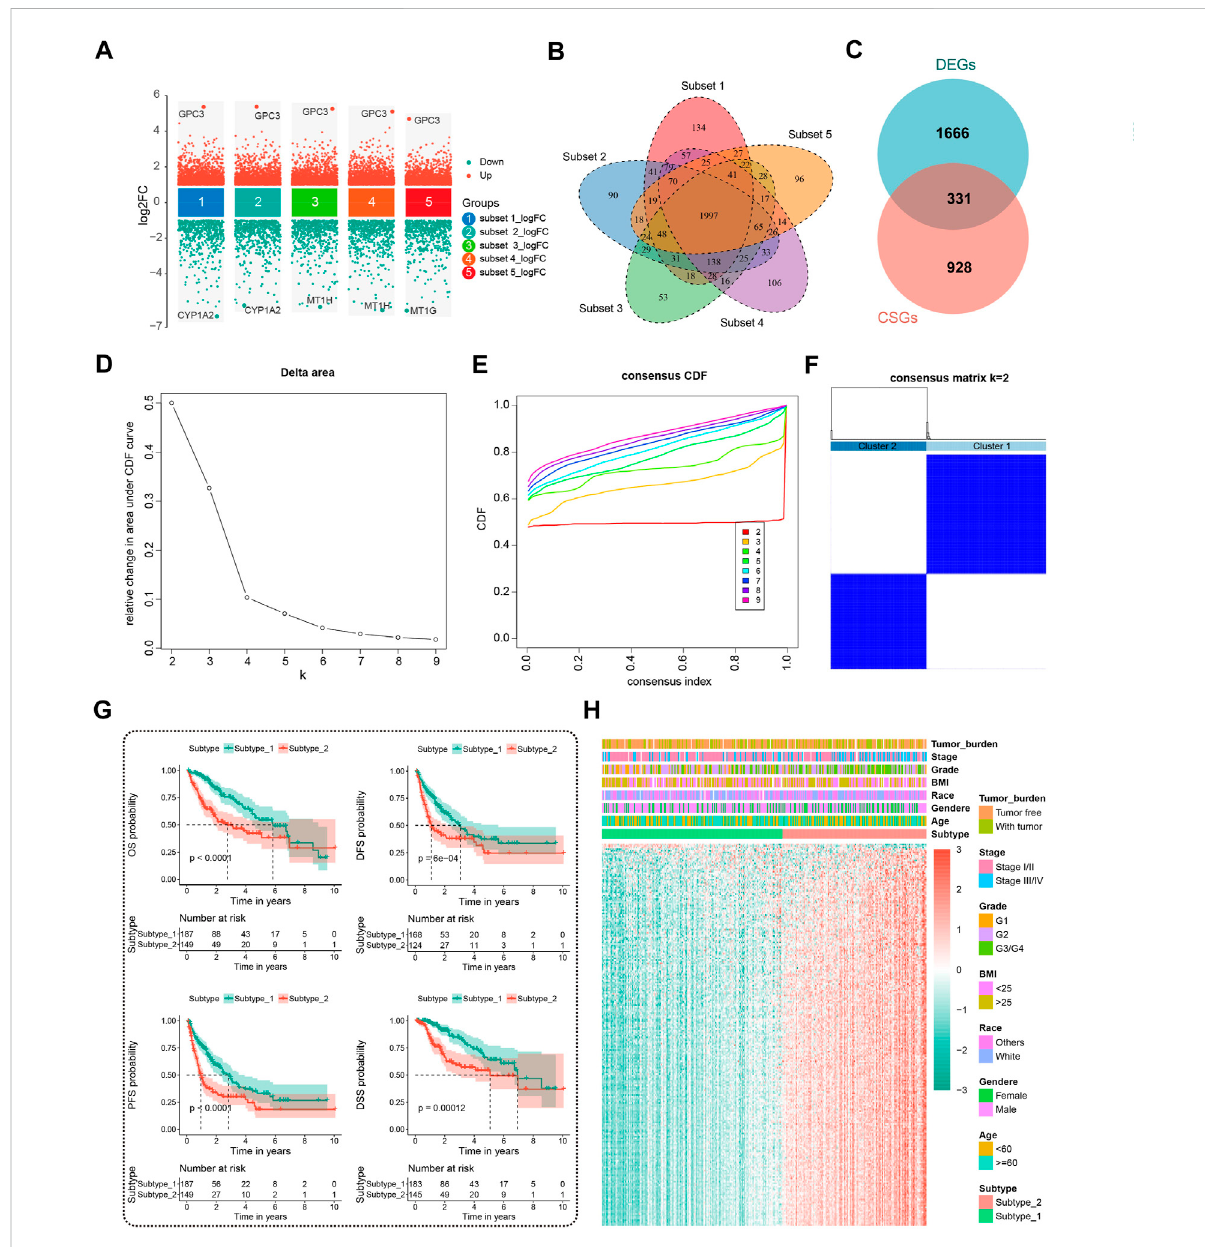
FIGURE 2 Identi fi cation of prognostic DECSGs and consensus clustering. (A) Screening of the DEGs in HCC with the subset-based approach. (B) Venn diagram showing the 1997 DEGs shared by the fi ve subset-based DEGs. (C) Venn diagram showing the 331 DECSGs in HCC. (D – F) Two subtypes of HCC were recognized with 238 robust prognostic CSGs using unsupervised consensus clustering. (G) Kaplan-Meier survival plots of two CSG subtypes for OS, DFS, PFS, and DSS. (H) The 238 gene pro fi les of two CSG subtypes with clinical traits. DECSGs, differentially expressed cellular senescencegenes;DEGs,differentiallyexpressedgenes;OS,overallsurvival;DFS,disease-freesurvival;PFS,progression-freesurvival;DSS,disease- speci fi c